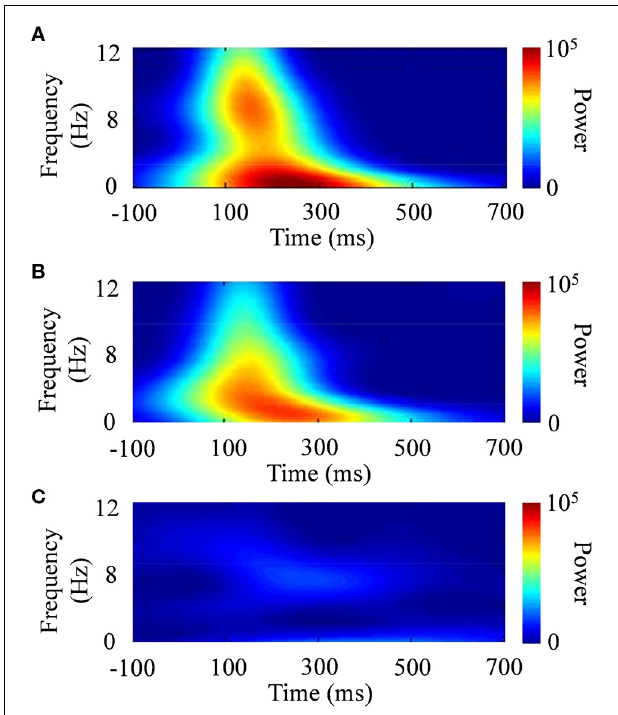
FIGURE 7 | Results of cross-validation using the SVM classifier. The SVM features (A) time–course and (B) time–frequency data.